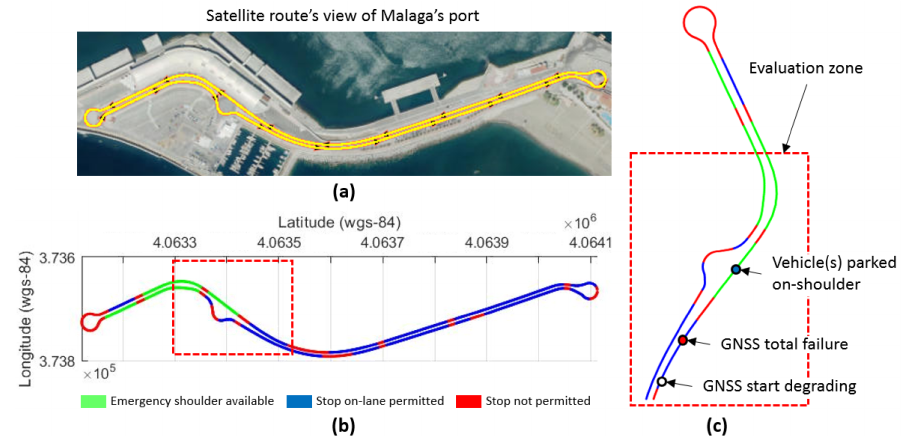
Figure 19. Realistic environment scenario for automated driving system tests on simulation. ( a ) Satellite’s view of urban route, ( b ) permitted and non-permitted stops in case of total positioning failure, and ( c ) evaluation zone for test case study. (image obtained from